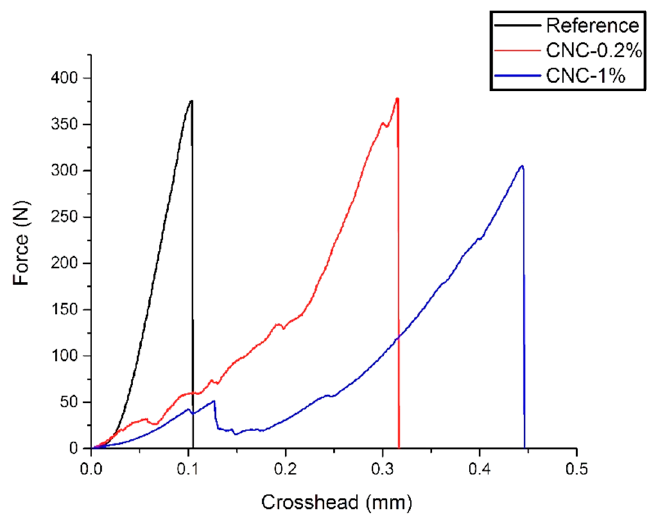
Figure 3. Three-point bending test for the seven days samples.